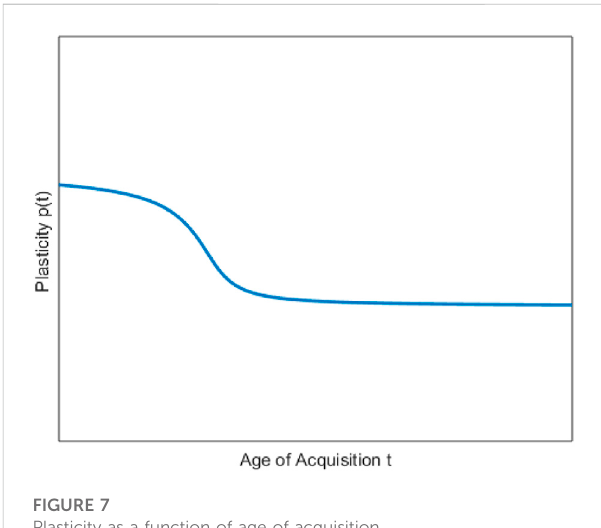
Plasticity as a function of age of